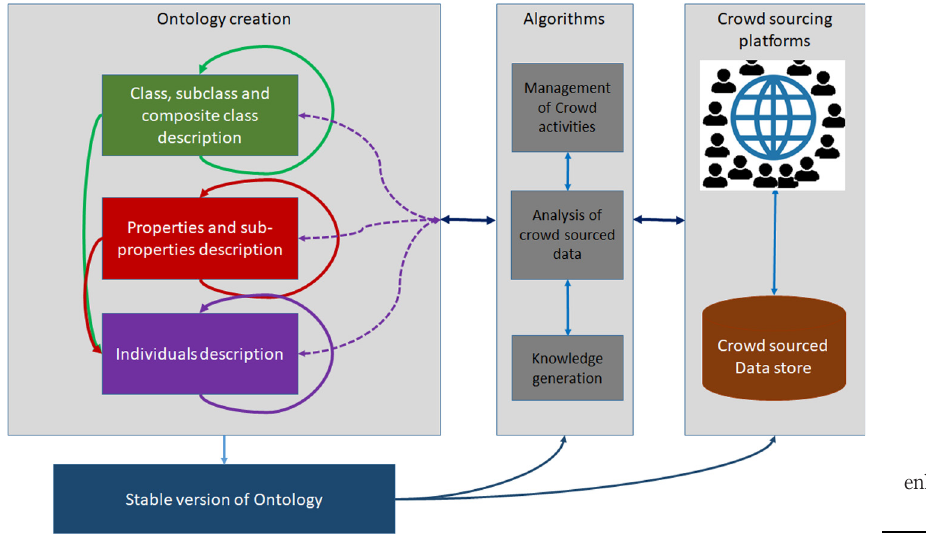
Figure 3. Conceptual architecture for ontology enhancement using